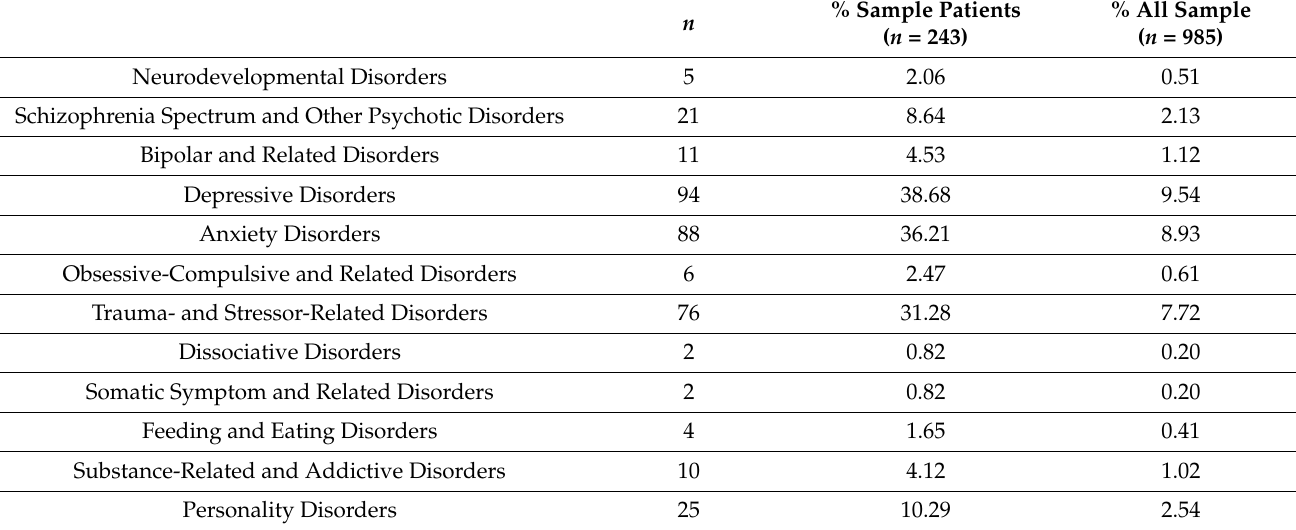
Table 2. Distribution of diagnoses in the patient